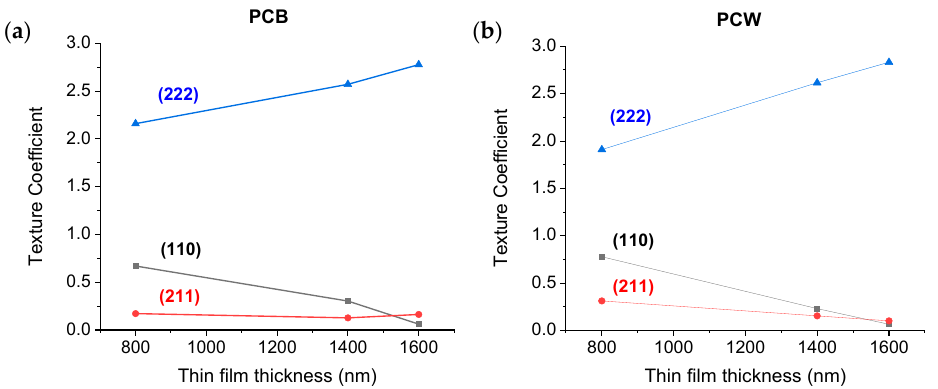
Figure 6. Texture coefficients of Cr films deposited over: ( a ) PCB and ( b ) PCW.